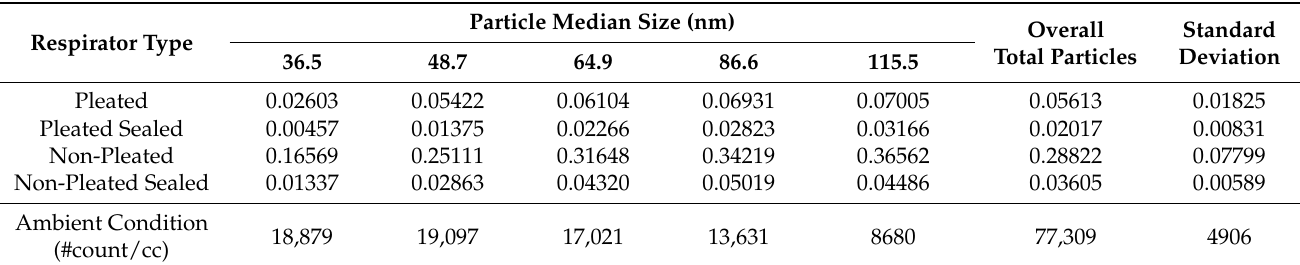
Table 2. Results of average downstream to upstream filtration ratios per type, particle size, and per respirator type at the Direct Airflow from MIG Welding.